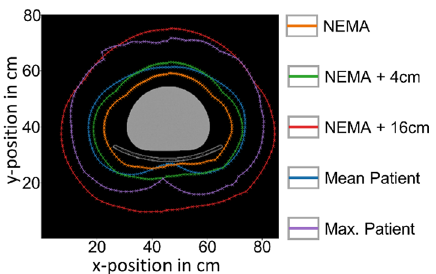
Fig. 4 CT of NEMA body phantom placed on patient bed with different gamma camera orbits. The orange contour illustrates the original NEMA detector orbit, which is used for the simulations of all activity distributions in the dataset. The green and the red contours represent two expanded versions of the NEMA detector orbit, used for analyzing the influence of deviations in detector orbit between training and input data on the u‑net performance. The blue and purple contours represent the mean and the maximum (maximum distance for every angle) patient detector orbits for all 436 SPECT/CT